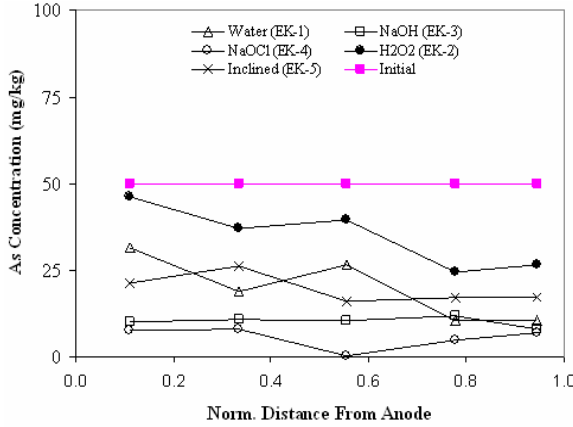
Figure 4 : Arsenic Concentration Profile of Treated